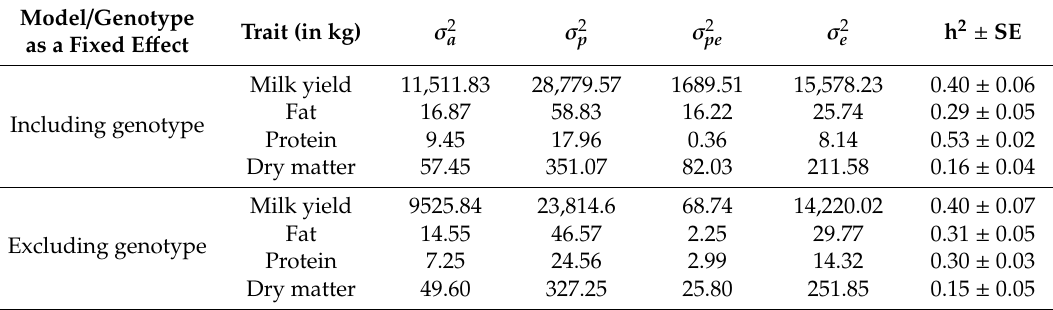
Table 2. Estimated components of variance, heritability (h 2 ) and standard error (SE) for milk yield (kg), protein, fat, and dry matter obtained from multivariate analyses through REML methods in goat milk including and excluding α S1-Casein genotype as a fixed e ff